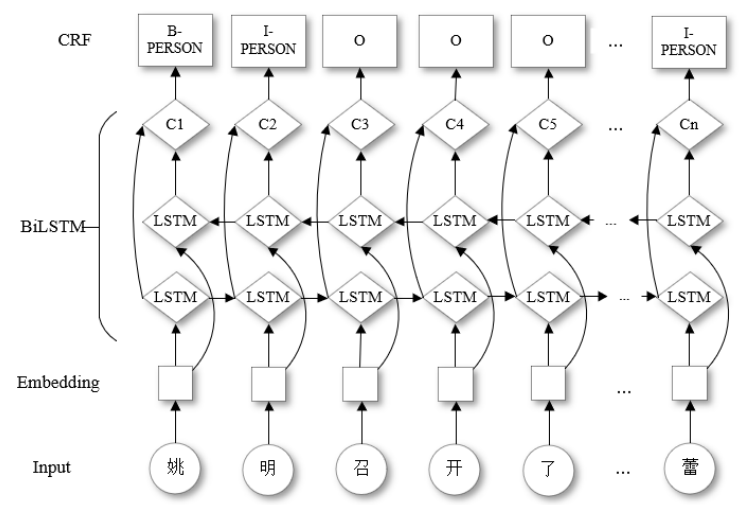
Figure 2. The main framework of the entity recognition model. The sequence of Chinese characters entered was: “Yao Ming held the first media meeting after returning to China and announced his daughter’s name. It turns out that Yao Ming’s daughter is Yao Qinlei”.